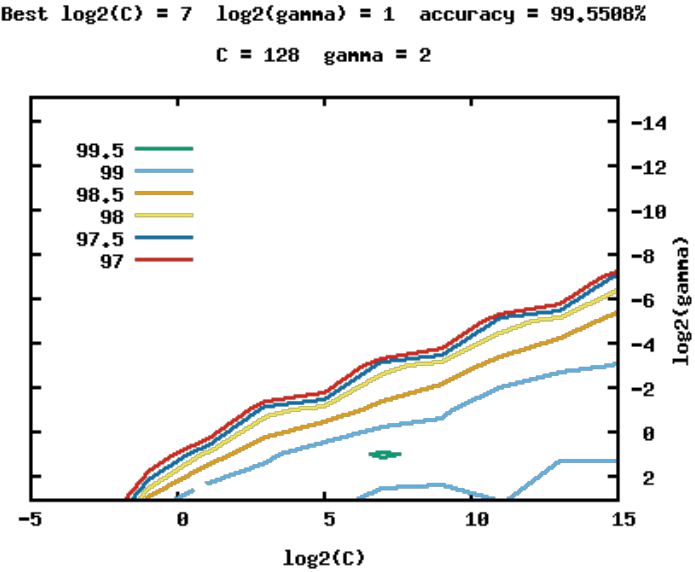
Figure 11. Accuracy-level curves during cross-validation for γ and C parameters in Experiment 1.